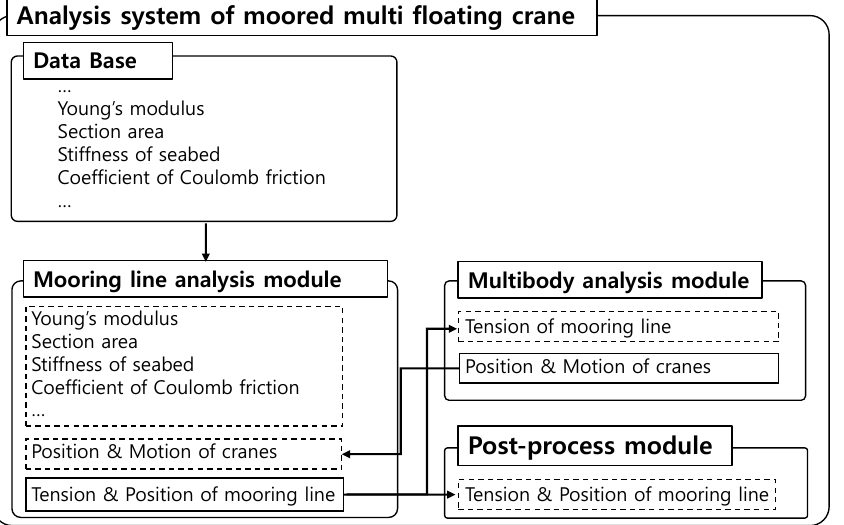
Figure 2. Interface design between mooring analysis module and multibody motion equation module.